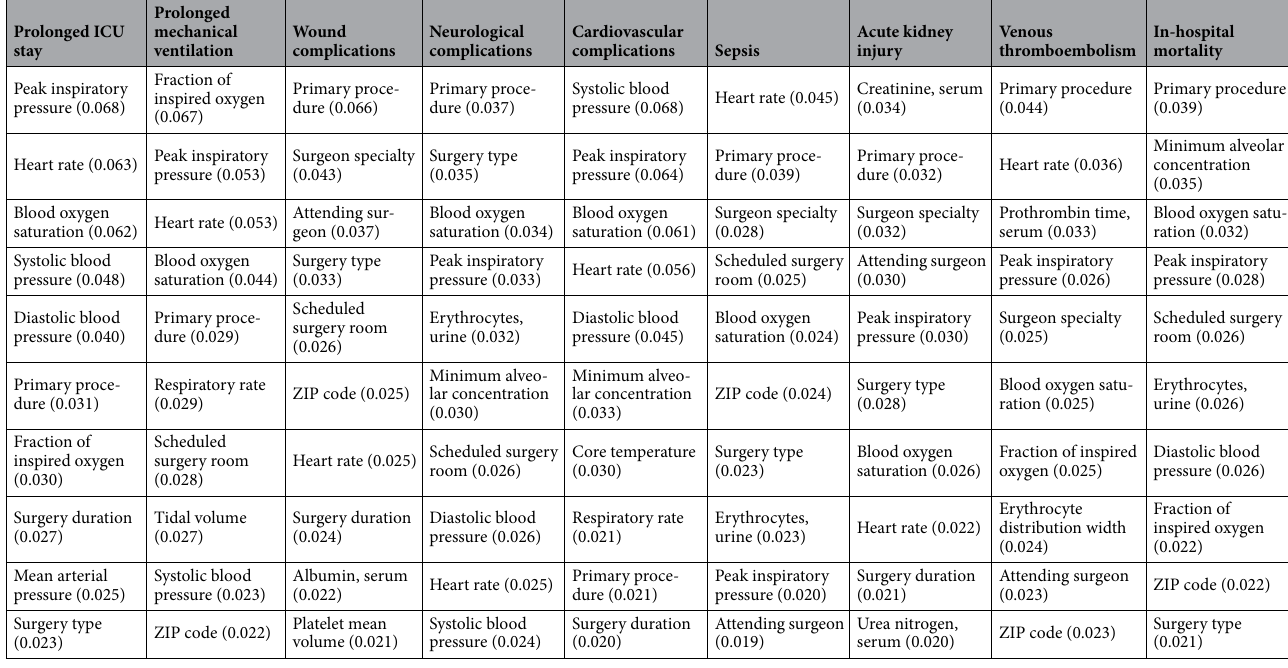
Table 3. The 10 most influential features using integrated gradients aggregated over validation